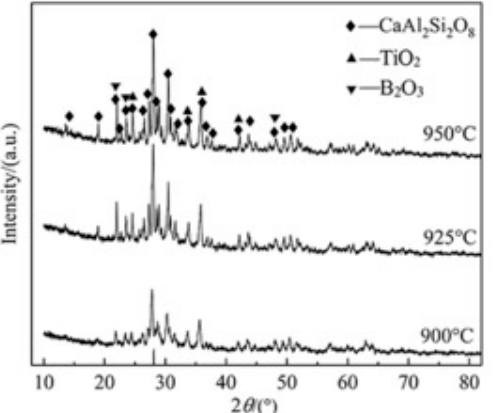
Figure 3. XRDpatternsofmicrocrystallineglassproductsobtainedatdifferentcrystallizationtemperatures. Figure 3. XRD patterns of microcrystalline glass products obtained at different crystallization tem- peratures.